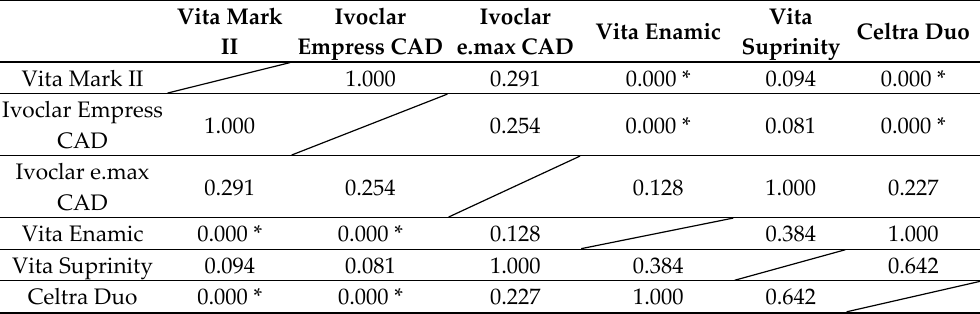
Table A7. Comparison of the different ceramics during the pull-off test: Multilink Implant.